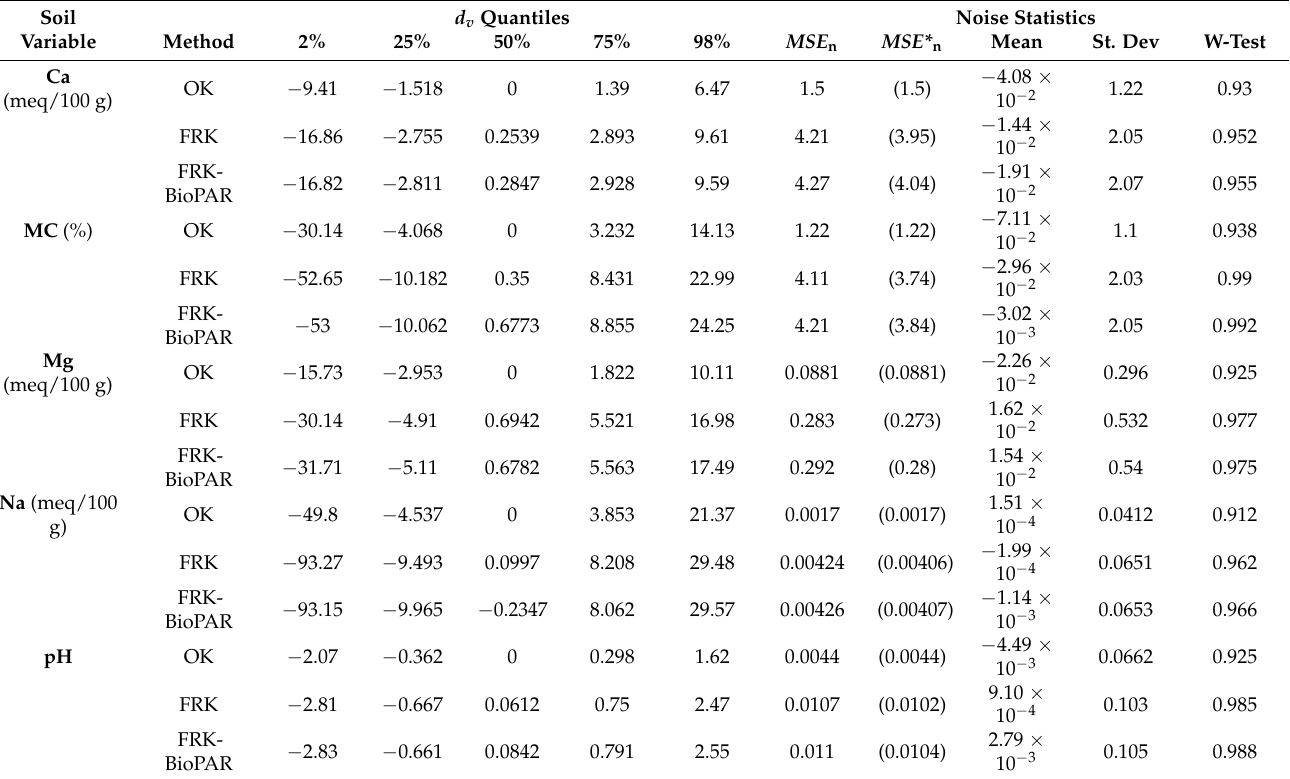
Table 9. Filtering performance of interpolation methods for different soil properties.